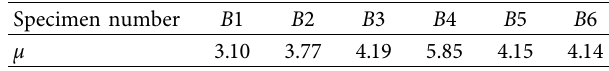
Figure 10: Effect of steel fiber admixture rate on modulus of elasticity. Table 4: Ductility calculation